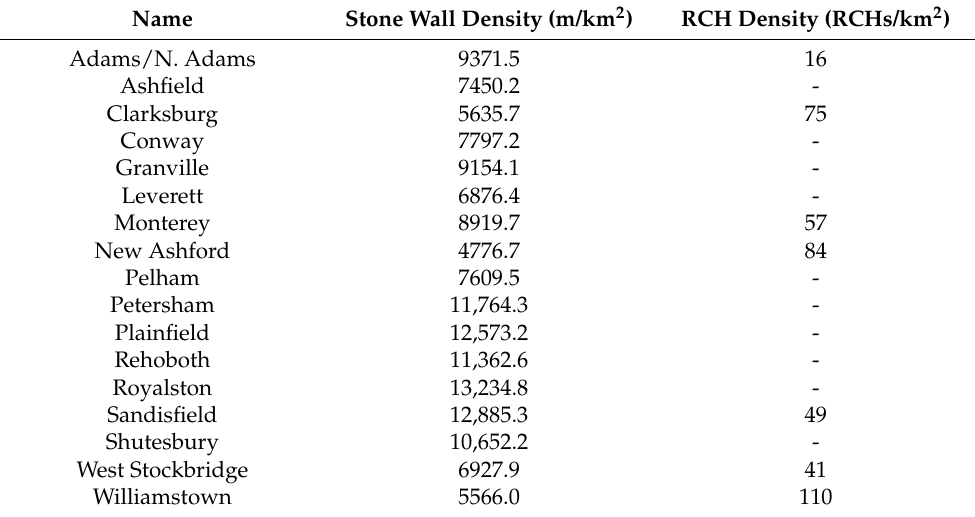
Table 2. Maximum density values for stone walls and relict charcoal hearths (RCHs) in study towns.